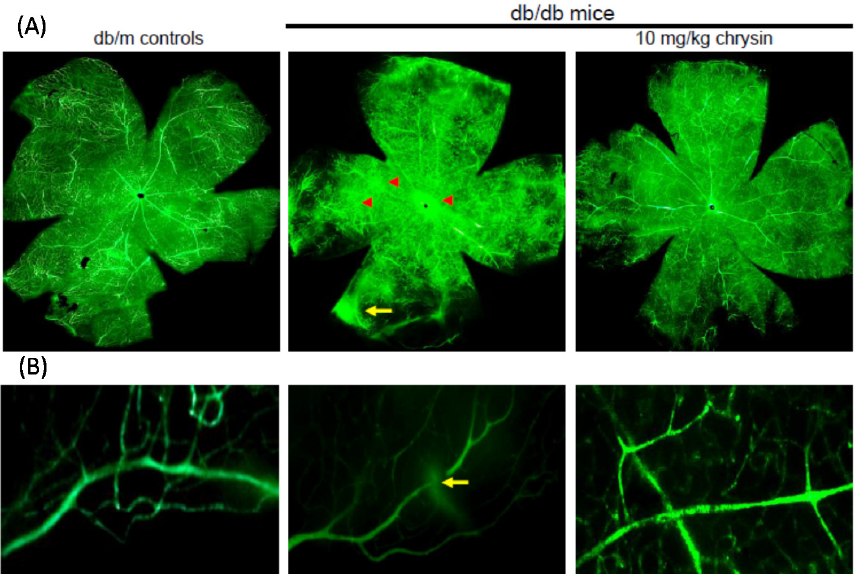
Figure 7. Blockade of new capillary bed formation ( A ) and vascular leakage ( B ) by chrysin. The db/db mice were orally treated with 10 mg/kg chrysin for 10 weeks and db/m mice were introduced as control animals. Typical appearance of ischemic retinopathy was observed by fluorescein ‐ dextran perfused retinal flat ‐ mounts. Retinas were dissected, flat mounted and observed by confocal microscopy. Magnification: 400×.